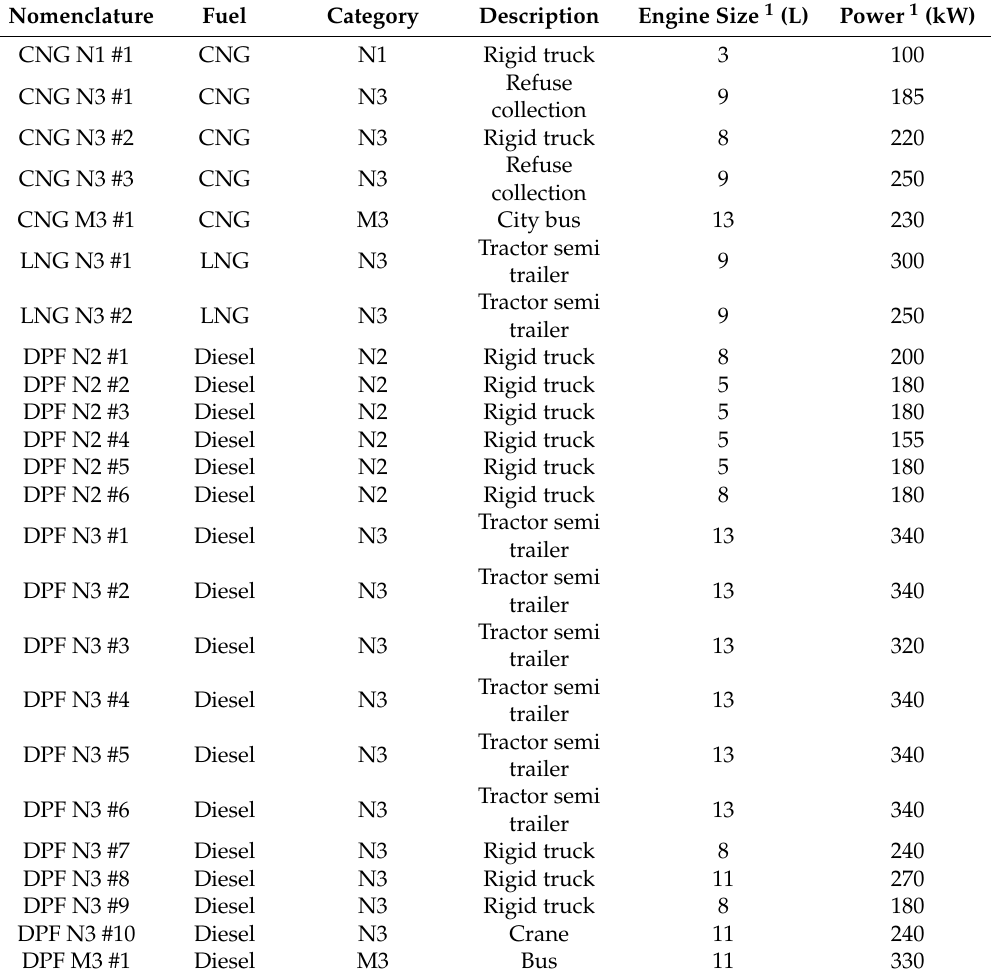
Table 1. Details of test